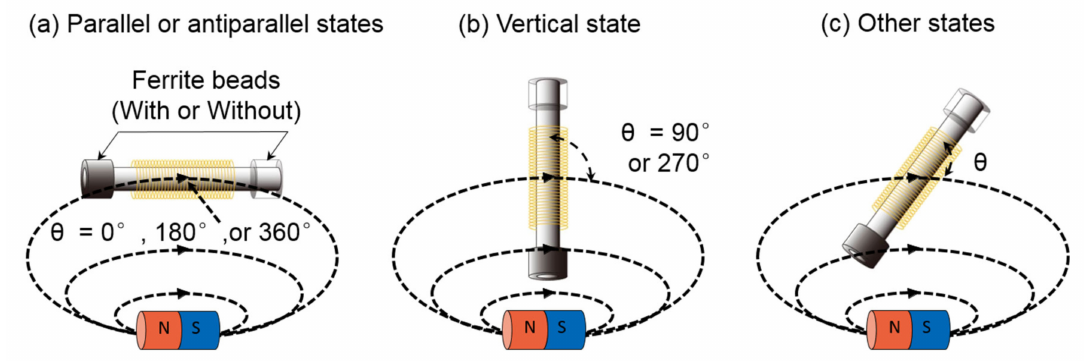
Figure 6. Angle (theta) diagram of the Wiegand sensor in the magnetic field: ( a ) parallel or antiparallel states, ( b ) vertical state, and ( c ) other